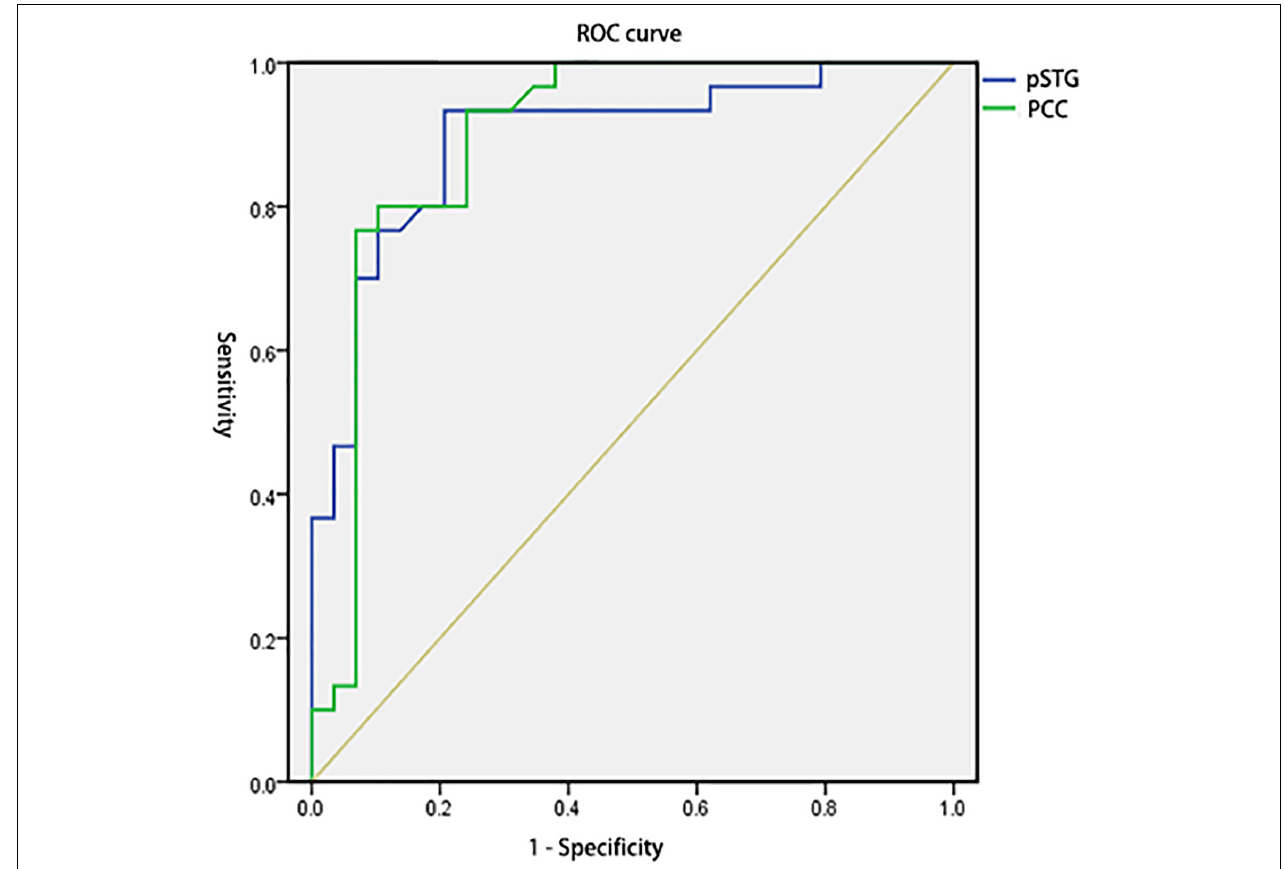
FIGURE 4 | Receiver operating characteristic curves (ROC) for differentiating the amusia from the control using the VMHC values in the pSTG and PCC identified by group analysis. VMHC, voxel-mirrored homotopic connectivity; pSTG, posterior superior temporal gyrus; PCC, posterior cingulate